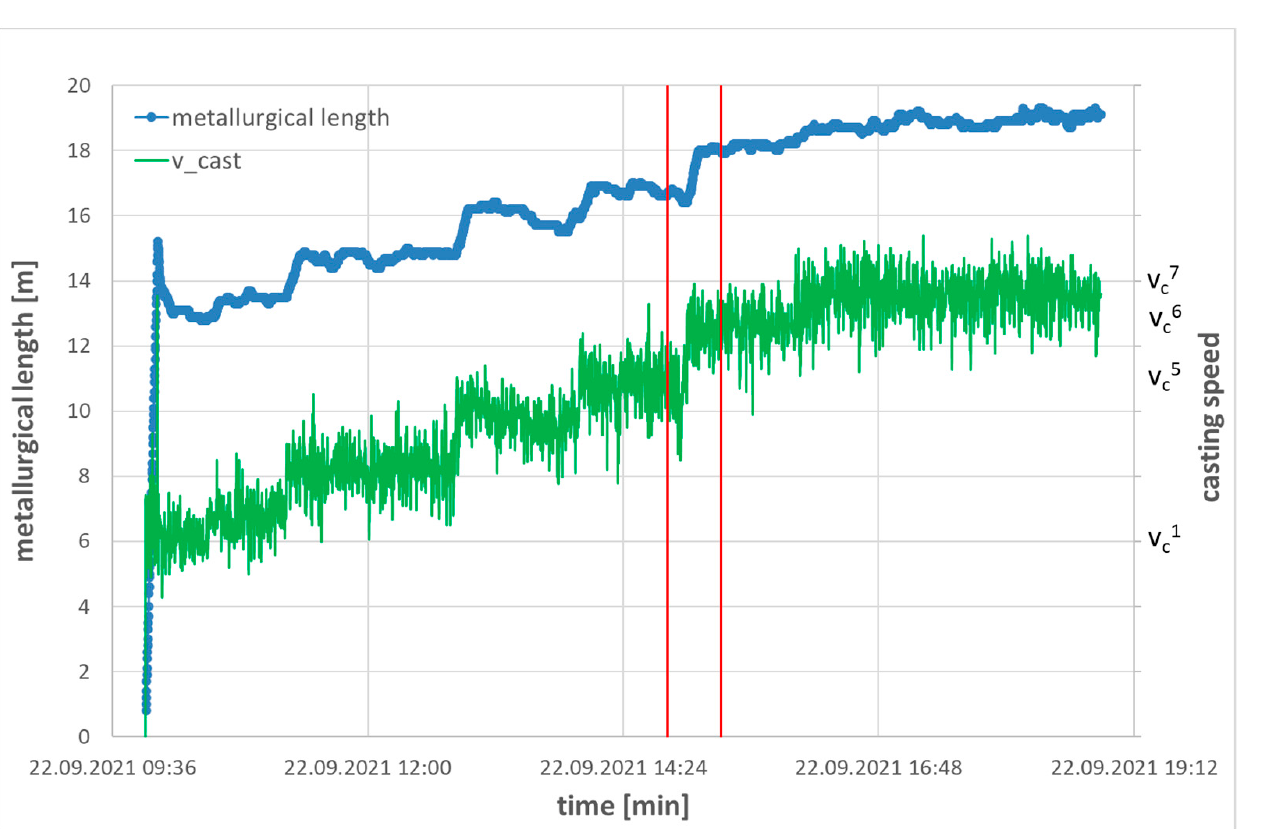
Figure 11. Evolution of casting speed and metallurgical length during the second vibrometer measurement campaign.